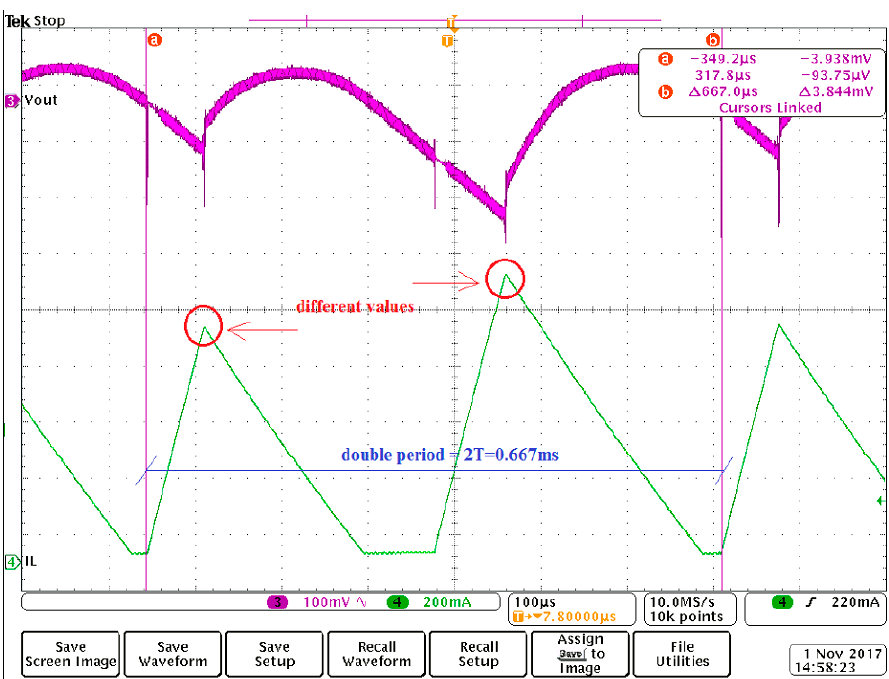
Figure 12. Inductor current and output voltage waveforms for k = 1.17. Notice that the peak inductor current values start to slightly differ in two consecutive periods and the period of the inductor current doubles compared to stable operation.